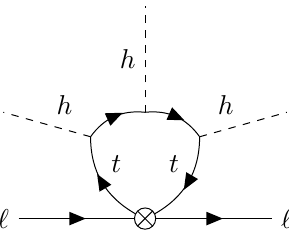
Figure 7 . One-loop diagrams appearing in the 2HDM matching to O 1 ,‘ . In the full theory, the operator insertion should be replaced by a heavy Higgs propagator, see appendix B.3 for